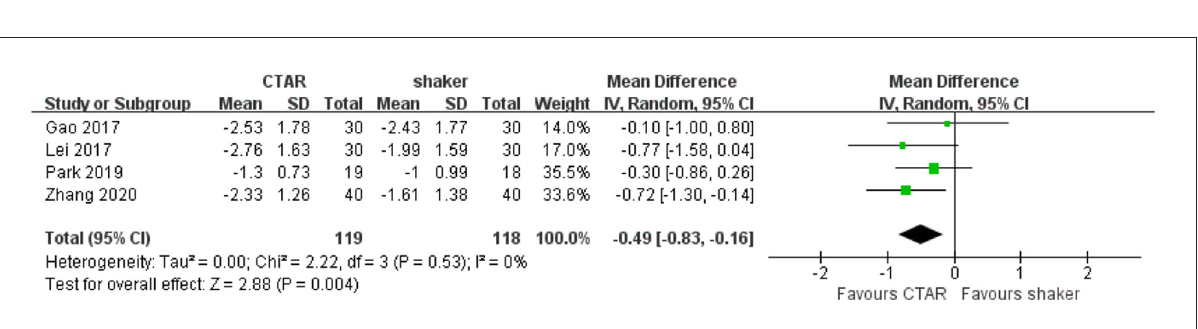
FIGURE6 Pooled changes of swallowing safety in CTAR exercise vs. Shaker